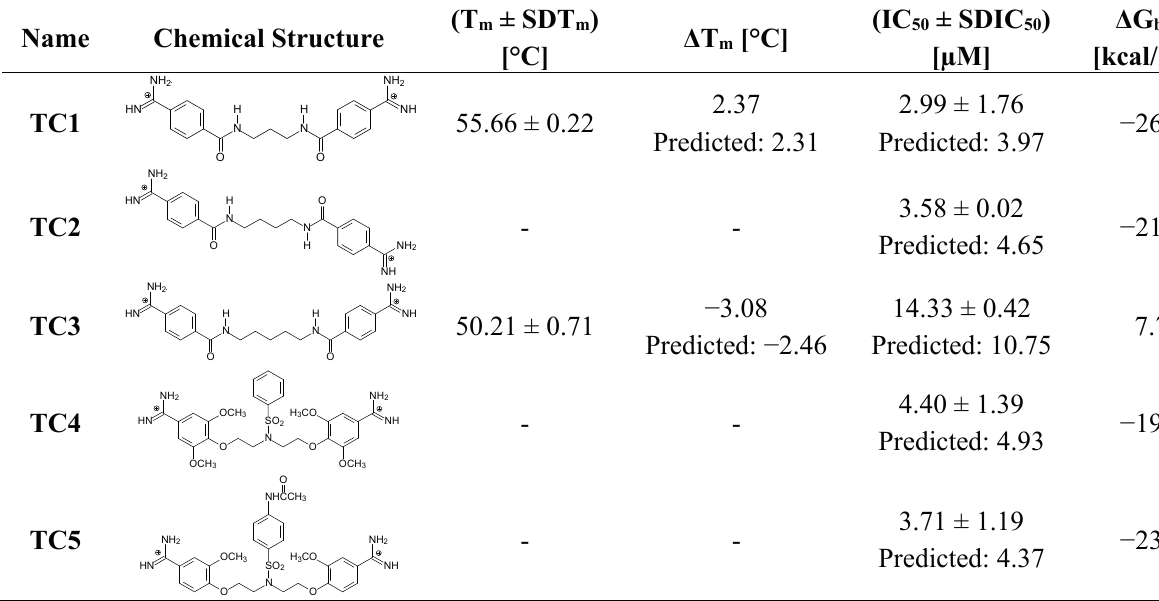
Table 2. Evaluation of models: testing compounds TC1 – TC5 ; experimental and theoretical parameters: Δ T m , IC 50 and Δ G bind